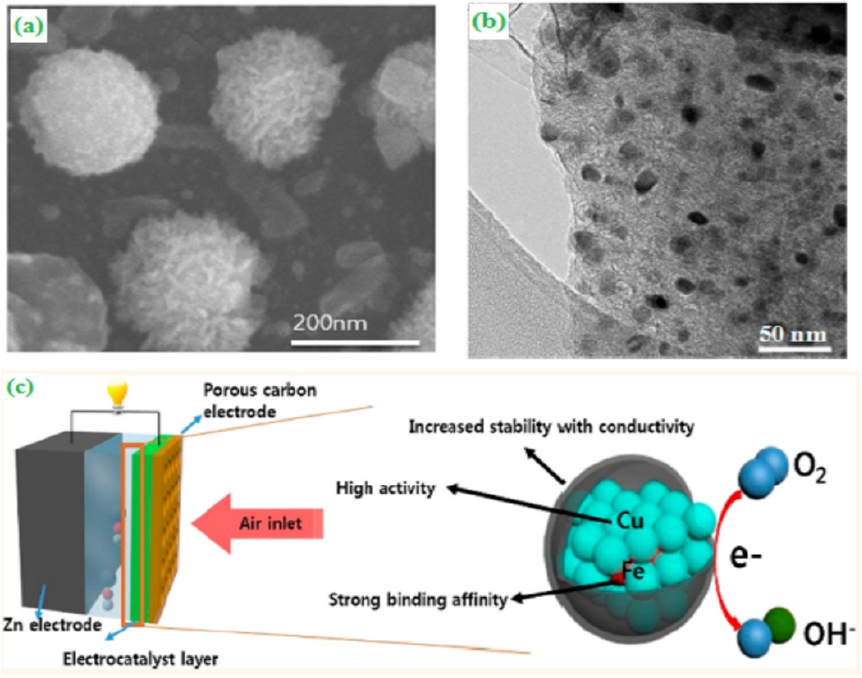
Figure 6. ( a ) SEM image of CuFe, ( b ) HR–TEM image of CuFe, and ( c ) schematic representation of ORR catalytic function of CuFe. Copyright 2015 by American Chemical Society [60]. ORR catalytic function of CuFe. Copyright 2015 by American Chemical Society